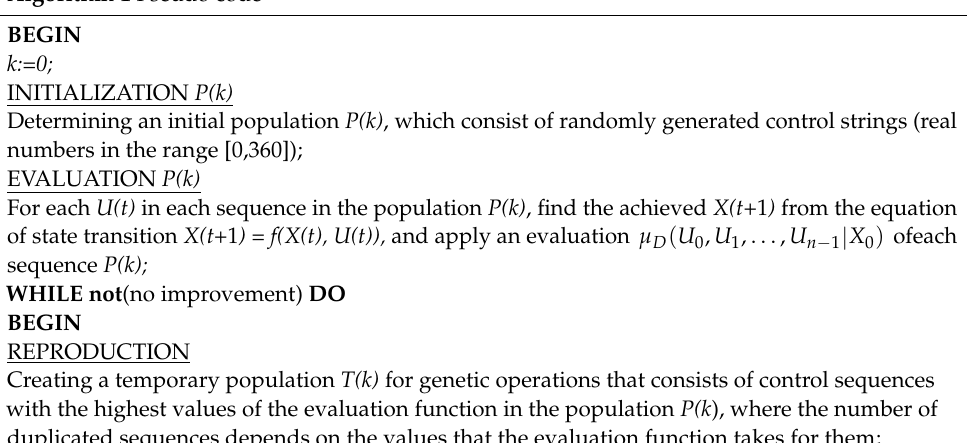
Algorithm 1 Pseudo